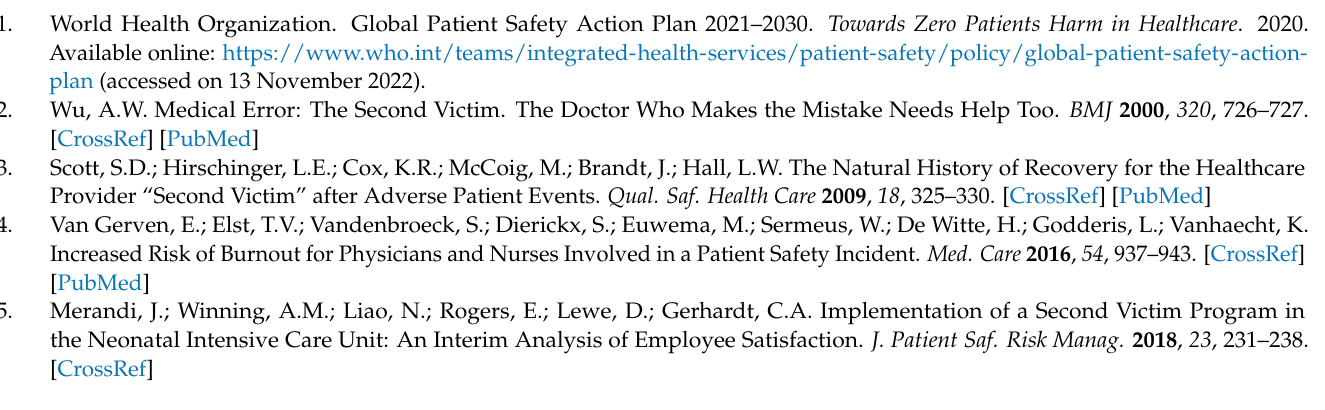
Table S2: Different concepts used in definitions and/or descriptions of